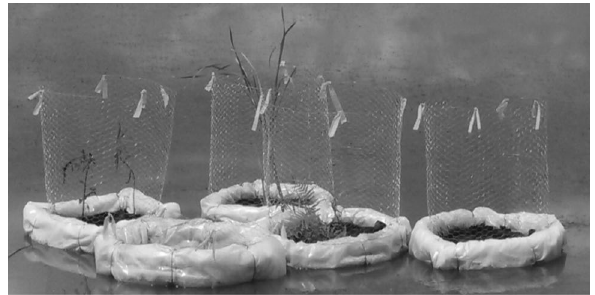
Fig. 3 One group of floating mats after planting. Fences were placed on the outside of treatments with peat moss to deter waterfowl from using the floating mats as a resting